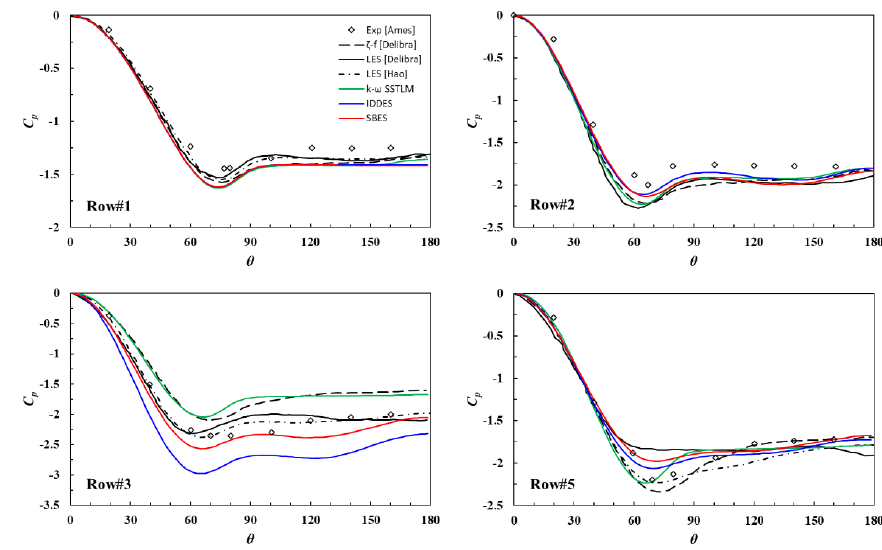
Figure 7. Pressure coefficient distributions along line C in rows 1, 2, 3, and 5.